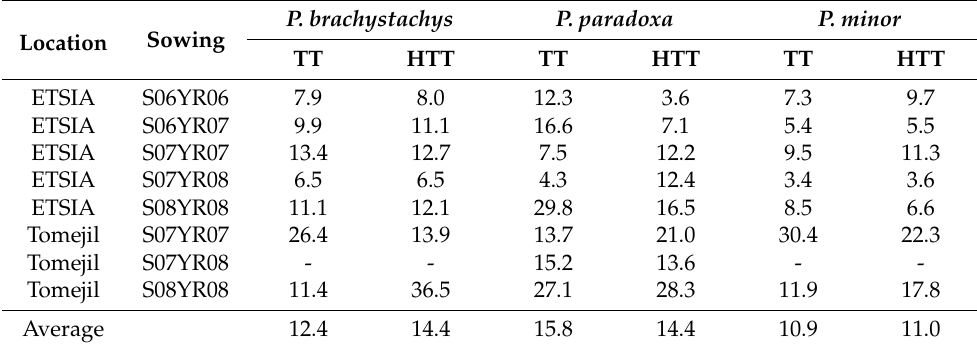
Table 8. Root mean square error (RMSE) values obtained from thermal (TT) and hydrothermal (HTT) time non-parametric models for each Phalaris species.